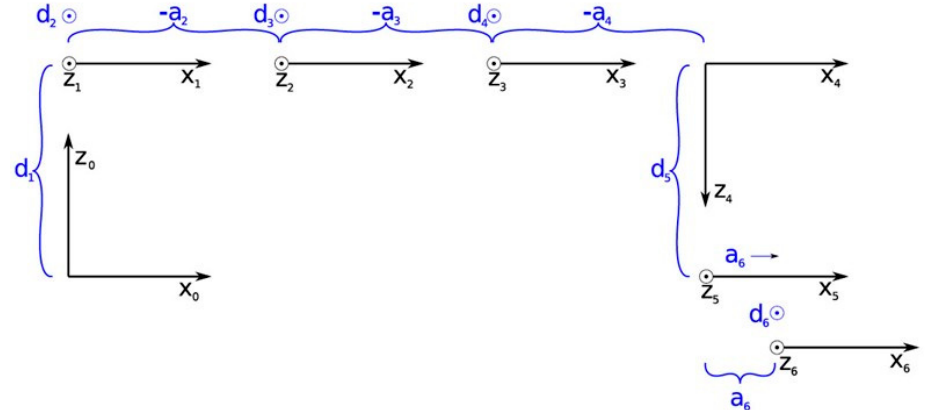
Figure 3. The Denavit–Hartenberg parameters notation for the UR3 manipulator. The singularity locus of the UR-3 manipulator can be found by solving |𝐽| = 0 . The manipulator lies in a singularity when: